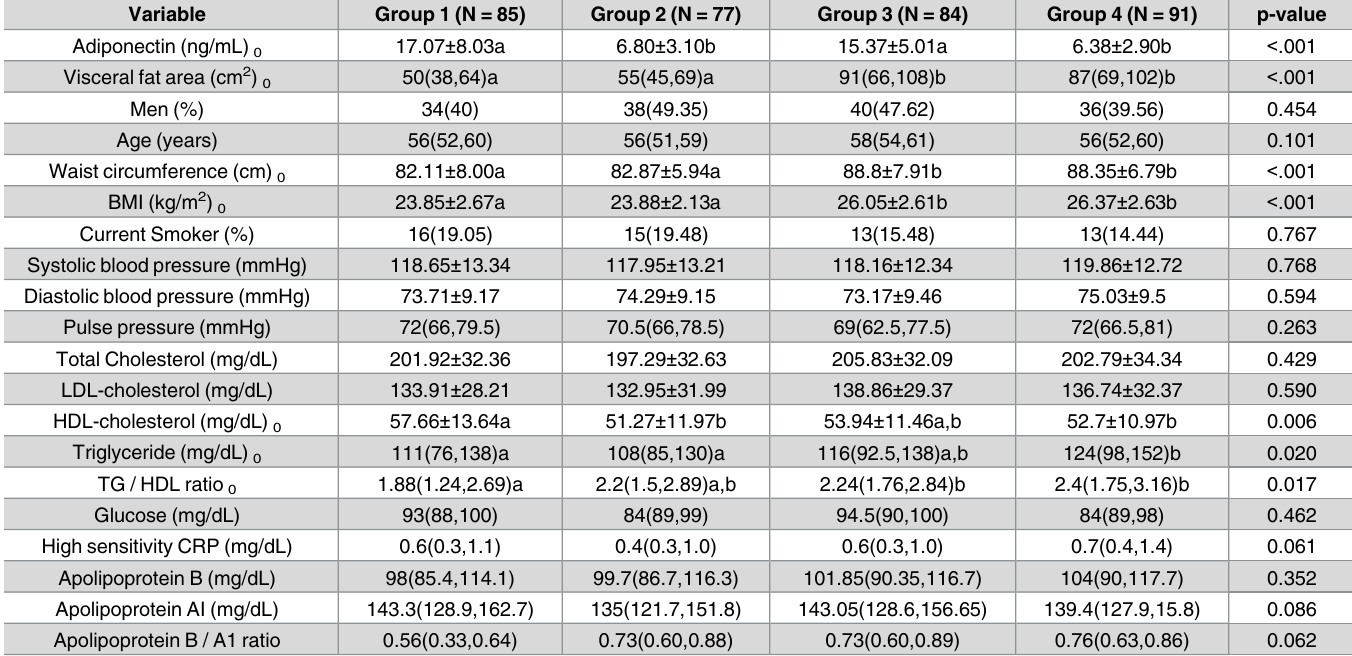
Table 1. Baseline